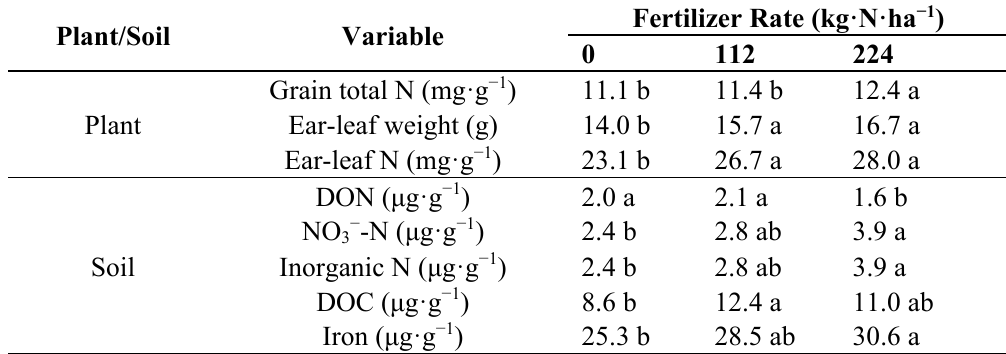
Table 4. Mean corn grain total nitrogen (N), ear-leaf weight, and ear-leaf N concentration, and soil dissolved organic N (DON), nitrate (NO 3 − -N), inorganic N, dissolved organic C (DOC), and Mehlich-3 extractable soil iron concentration as affected by fertilizer